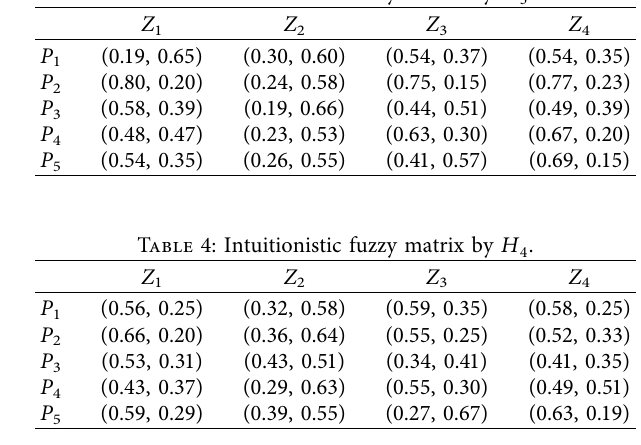
Table 5: Intuitionistic fuzzy matrix by H